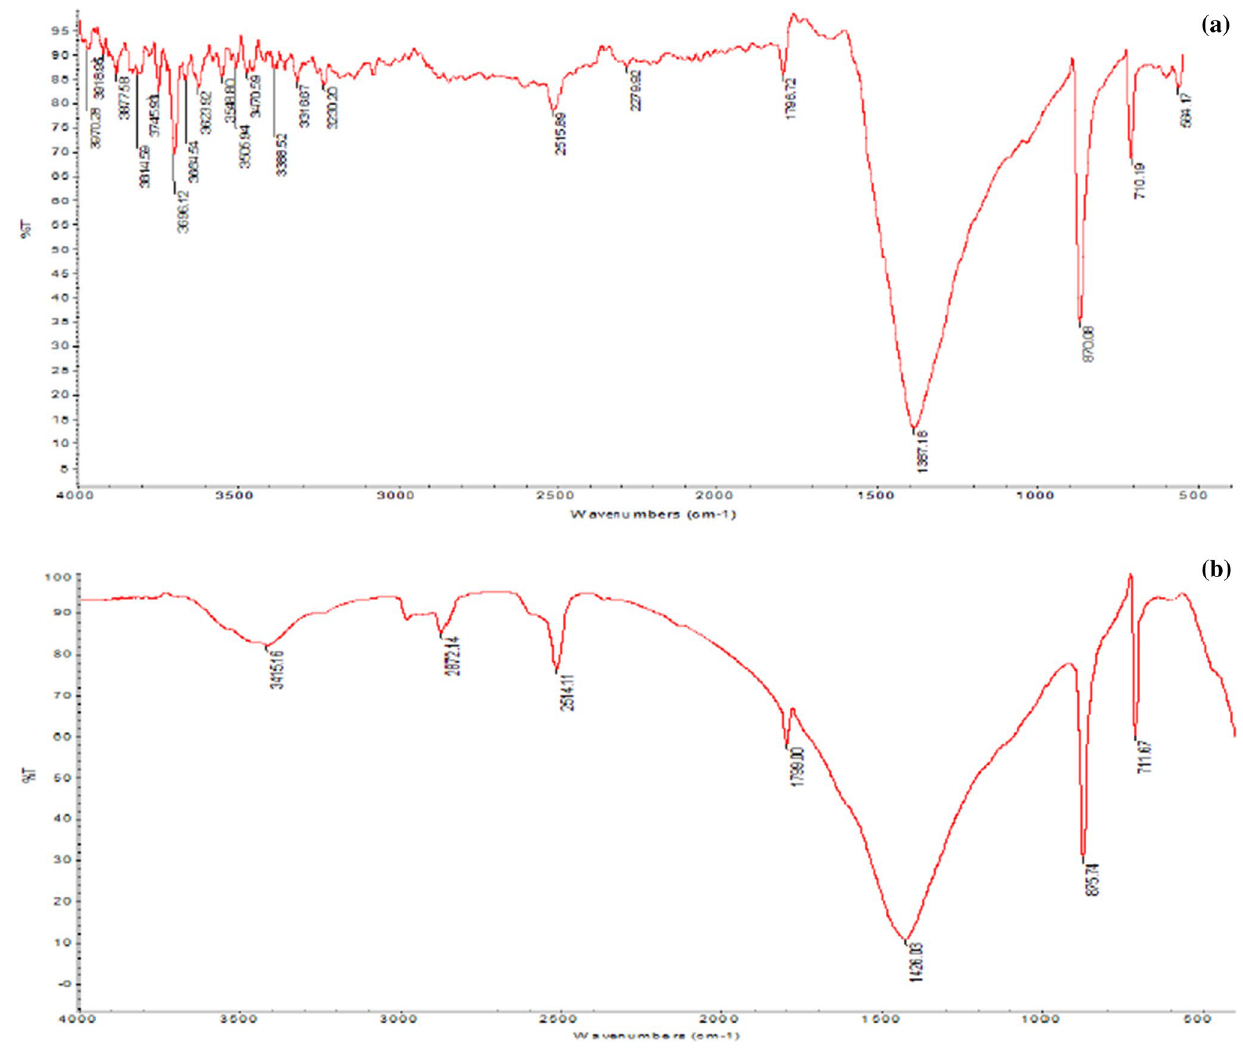
Fig. 3 FTIR spectrum for a Magnesia-1 b Magnesia LS following the F − adsorption